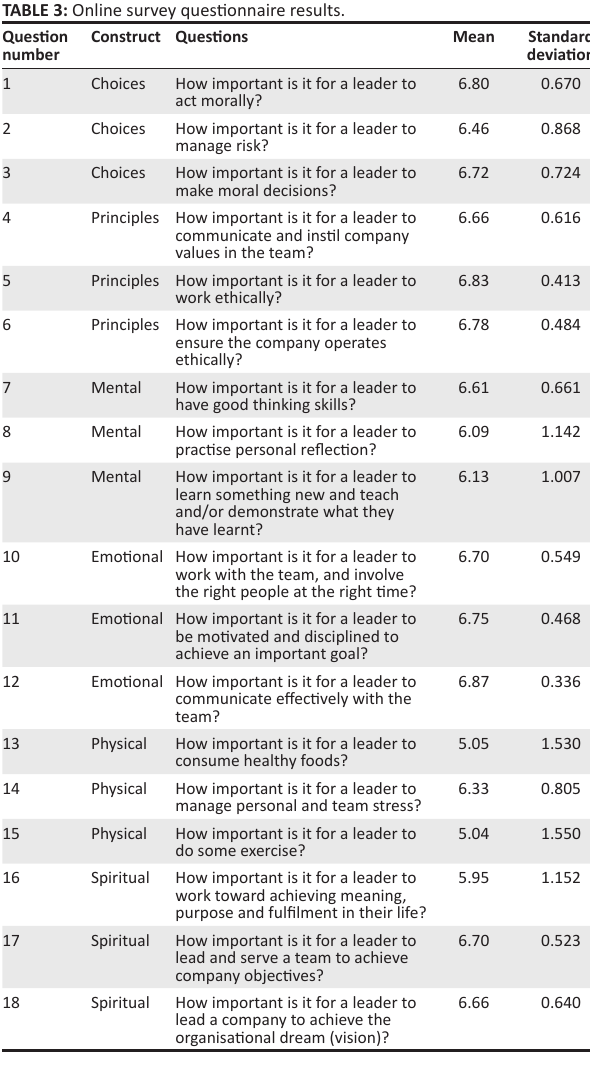
FIGURE 2 : Confirmatory factor